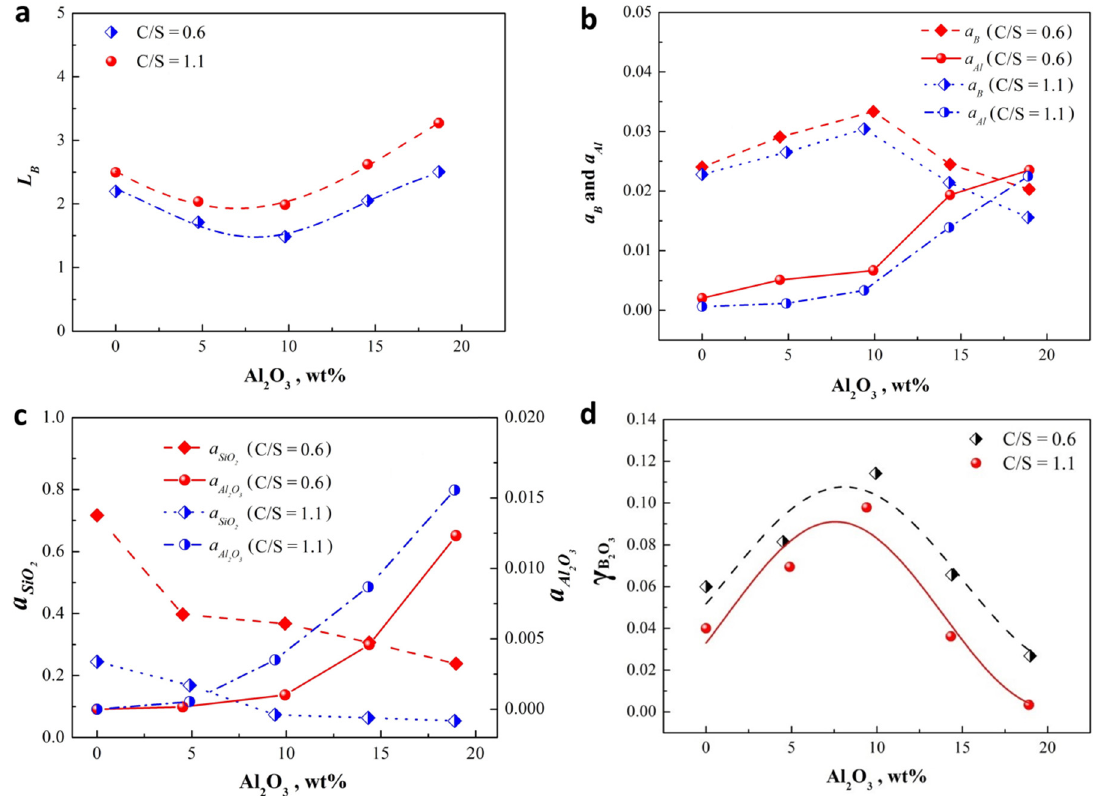
Figure 2. ( a ) B partition ratio between CaO-SiO 2 -Al 2 O 3 slag and Si phase for different Al 2 O 3 content and basicity at 1823 K. ( b ) Activity of B and Al in the Si-Ca-Al-B quaternary system at 1823 K. ( c ) Activity of SiO 2 and Al 2 O 3 in the CaO-SiO 2 -Al 2 O 3 ternary system at 1823 K. ( d ) Activity coefficient of B 2 O 3 for the CaO-SiO 2 -Al 2 O 3 slag at 1823 K as a function of Al 2 O 3 content and basicity.